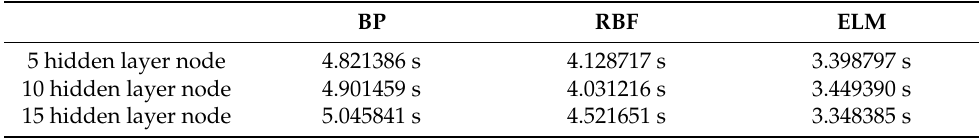
Table 5. Comparison of running times of different